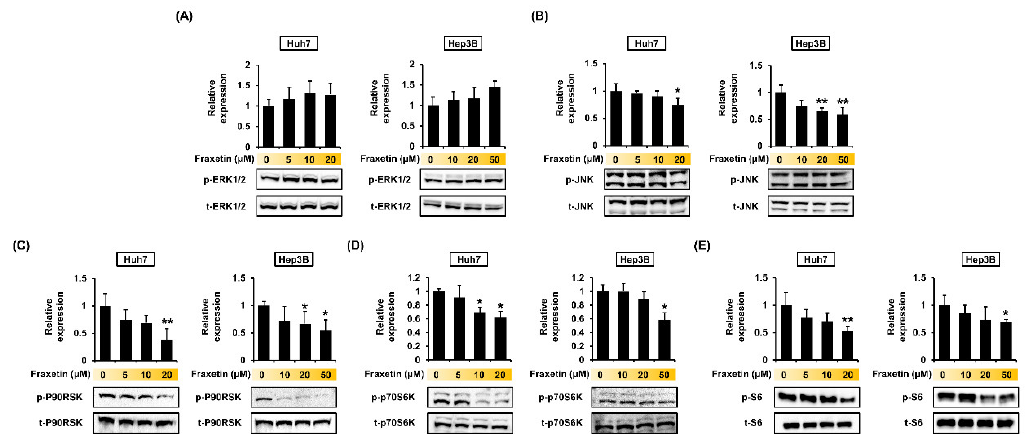
Figure 7. Regulation of mitogen activated protein kinase (MAPK) and phosphoinositide 3-kinase (PI3K) signaling pathways by fraxetin in hepatocellular carcinoma cells. ( A – E ) Phosphorylation of ERK1/2 ( A ), JNK ( B ), P90RSK ( C ), P70S6K ( D ) and S6 ( E ) in response to increasing doses of fraxetin. Asterisks indicate the significance levels of comparisons between vehicle-treated cells and fraxetin-treated cells (* p < 0.05 and ** p < 0.01).